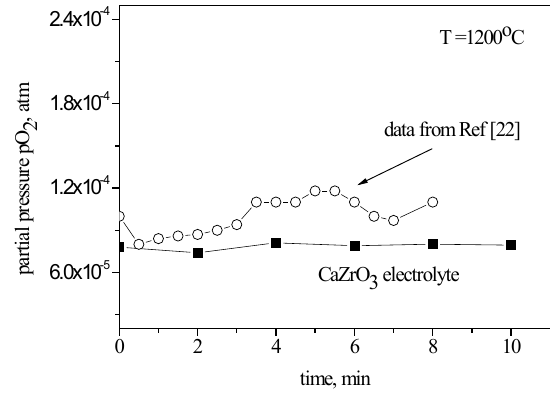
Figure 12. The variation of pO in liquid copper during the 2 deoxidation process; 0.2 mass % of initial manganese -sintered 3 content was